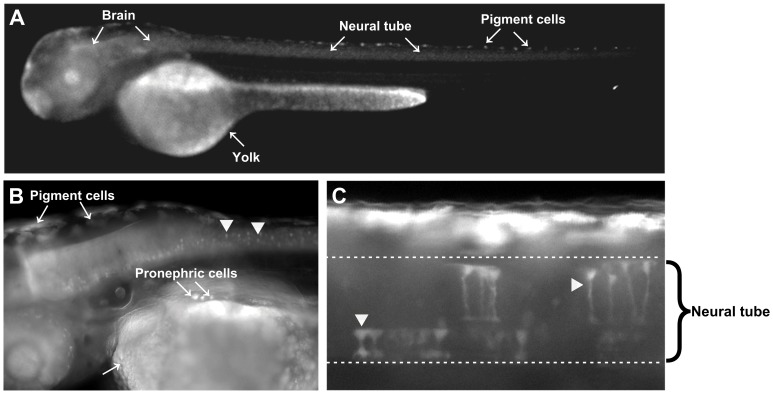
Specificity of ATP1A3 promoter driven expression of GFP in zebrafish embryos.
A. and B. Weak GFP expression in the central nervous system and cells of the pronephros in F1 embryo 54 hours post fertilization. C. Mosaic expression in individual cells of the neural tube driven by the ATP1A3 promoter in a representative embryo of the injected generation.